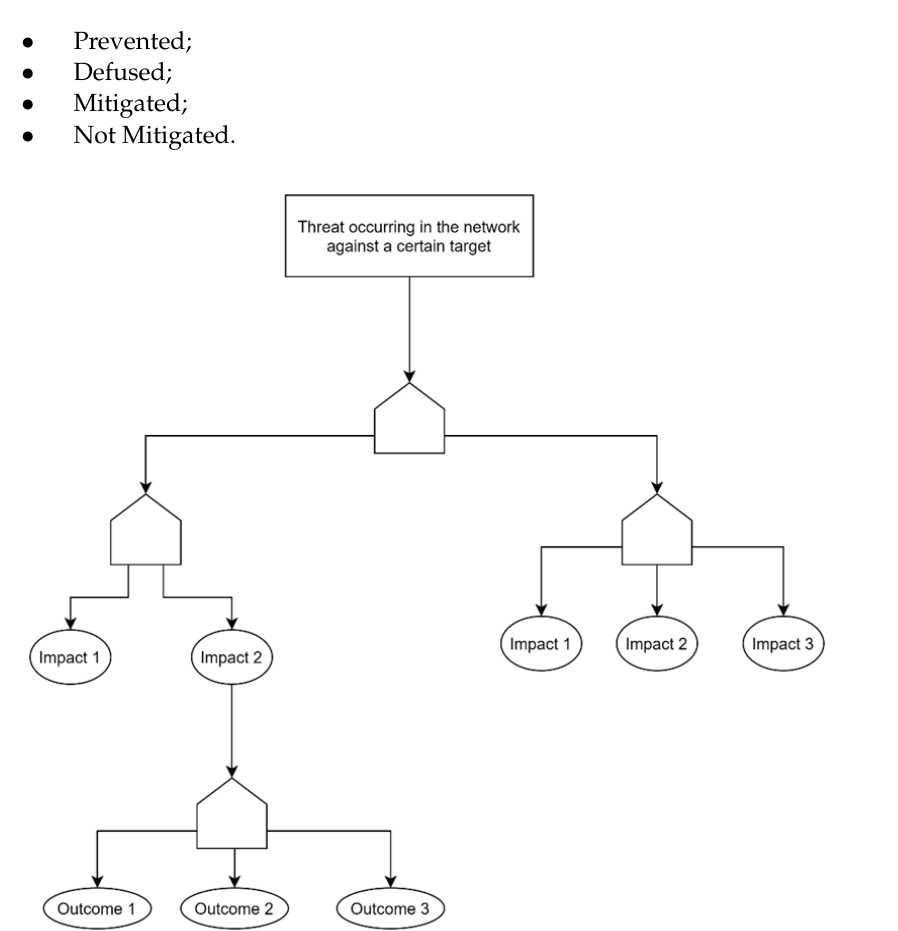
Figure 2. Algorithm’s topology structure—tree model.